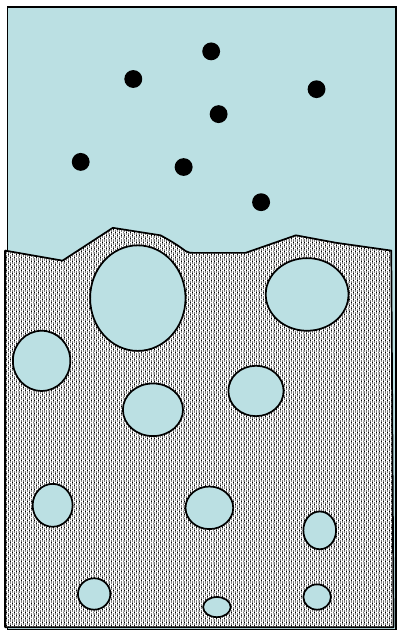
Figure 23. Bubbling Fluidized Bed Hydrodynamics.